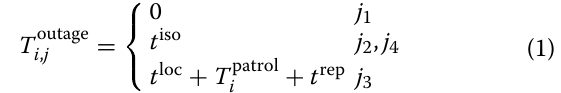
Table 1 Feature comparison of different models Feature [8] [9–